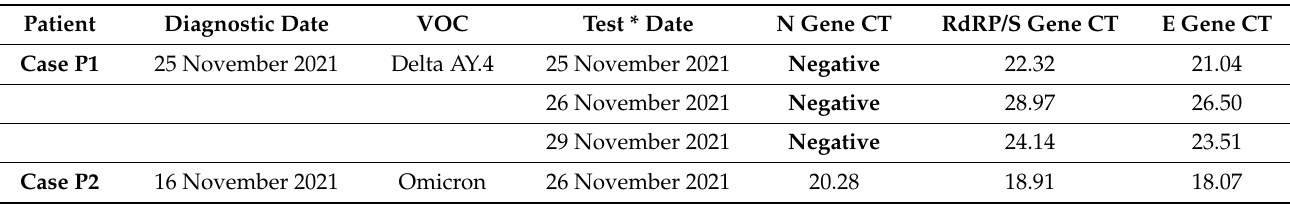
Table 1. Patients’ characteristics at different time-points with their relevant results.